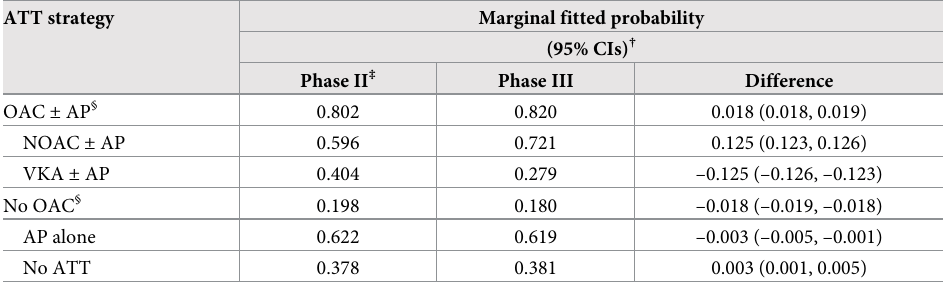
AP, antiplatelets; ATT, antithrombotic treatment; CI, confidence interval; NOAC, novel/nonvitamin K